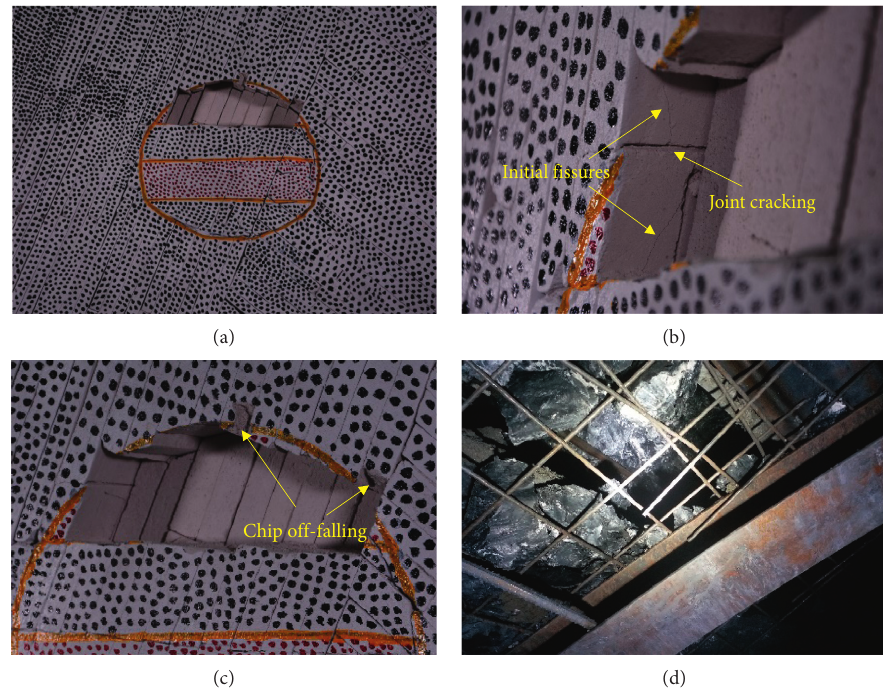
Figure 8: First excavation stage (E1 and E2) and deformations of surrounding rocks.